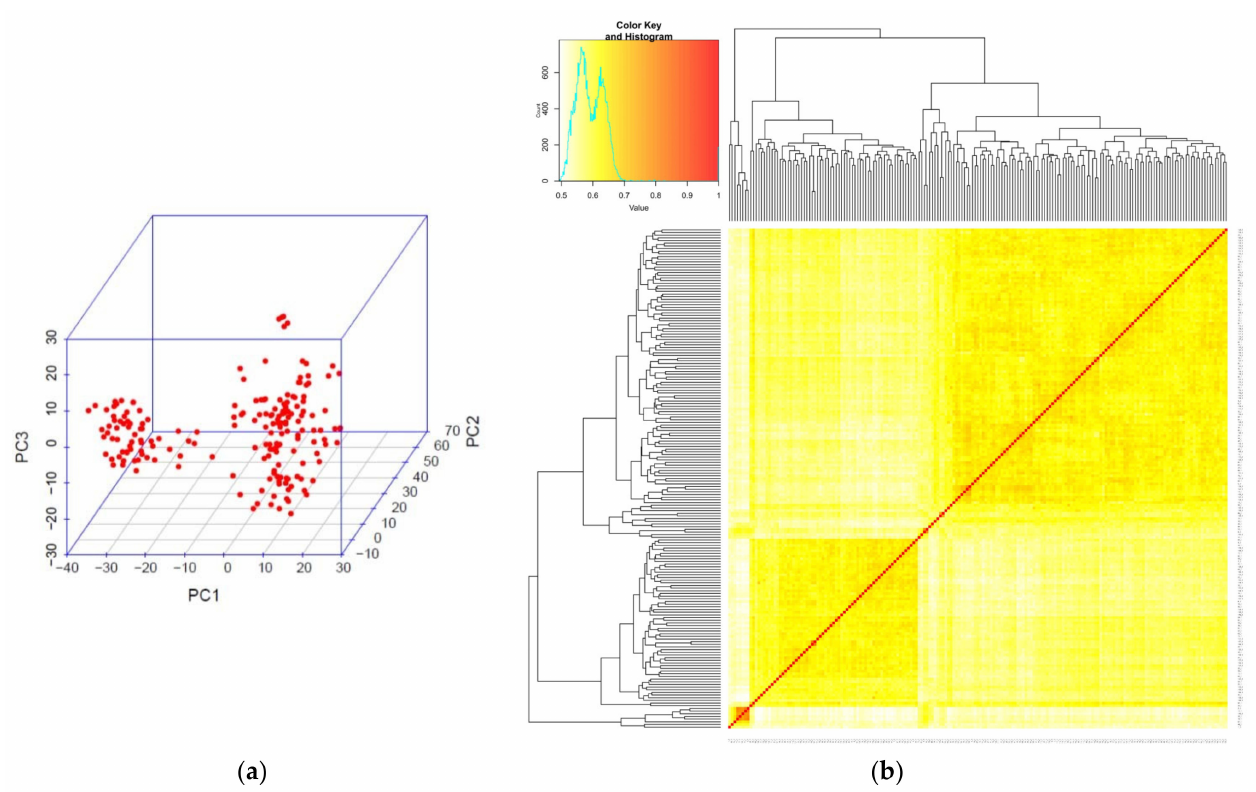
Figure 2. ( a ) Three-dimensional plot of the first three principal components showing the genetic differences among 185 RILs and parents. ( b ) The heat map developed from 6734 SNP markers showed clustering of 185 RILs and